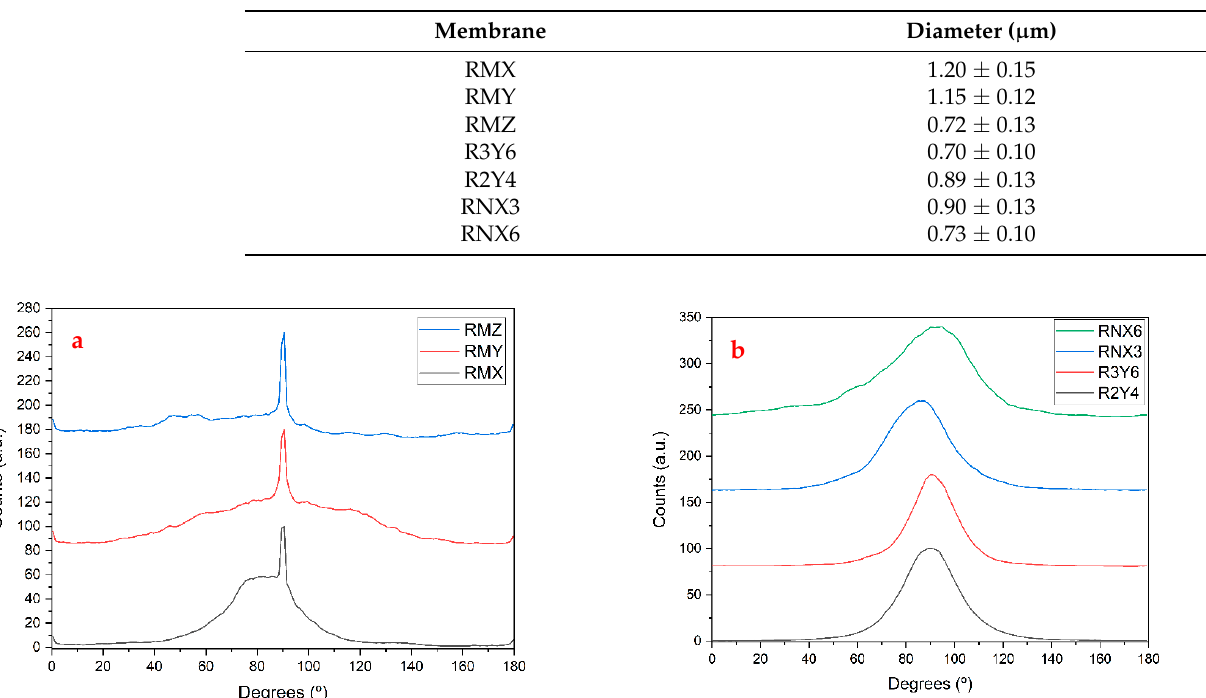
Figure 3. Alignment distribution graphs: ( a ) membranes without particles and ( b ) membranes with particles.